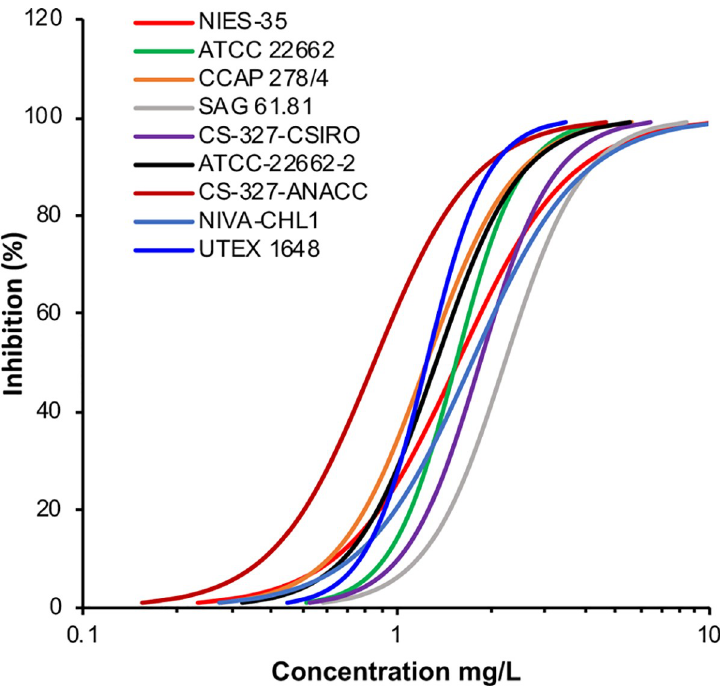
Fig 4. Dose-response curves based on the data from the growth inhibition test with 3,5-dichlorophenol.